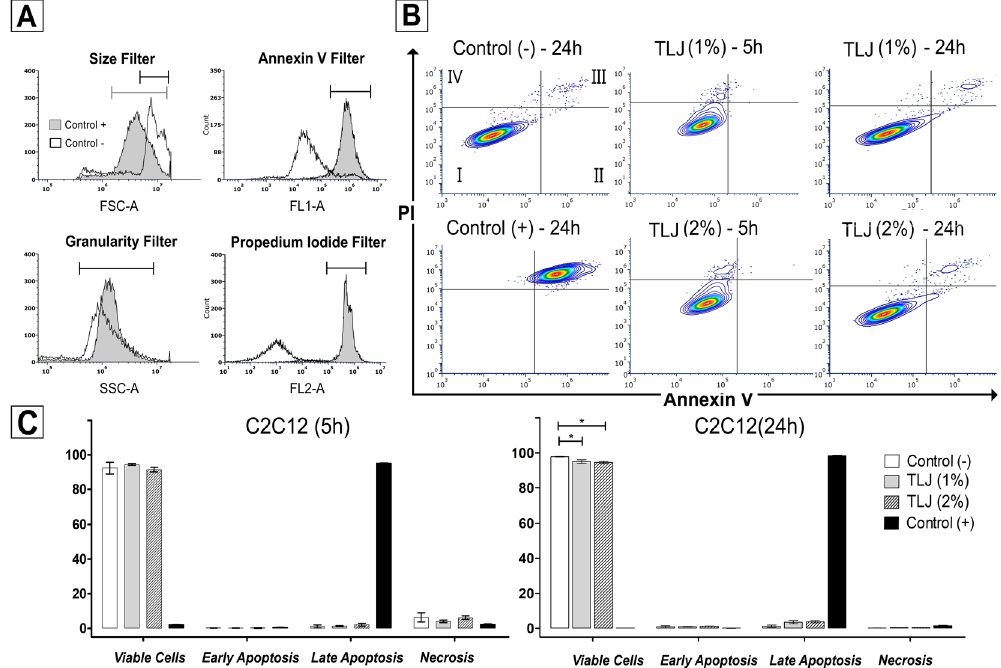
Figure 1. Absence of apoptotic and necrotic effects on C2C12 exposed to 1% or 2% of buffered TLJ for 5 or 24 h, analyzed by flow cytometry using AnnexinV and propidium iodide (PI) staining. ( A ) Filters used for classification of the cells; ( B ) Contour plot showing the distribution of cells classify as viable (I: PI − /Annexin V − ), early apoptosis (II: PI − /Annexin V + ), late apoptosis (III: PI + /Annexin V + ) and necrosis (IV: PI + / Annexin V − ) of the groups treated with 11 µ M of H 2 O 2 (control + ), 1% or 2% of TLJ buffered for 5 or 24 h. ( C ) Bar charts showing the numeric results of the classified groups (mean ± SEM, n = 3). Statistical Analysis: ANOVA accompanied by the Dunnett’s Multiple Comparison test using the control ( − ) group as reference; * p < 0.05